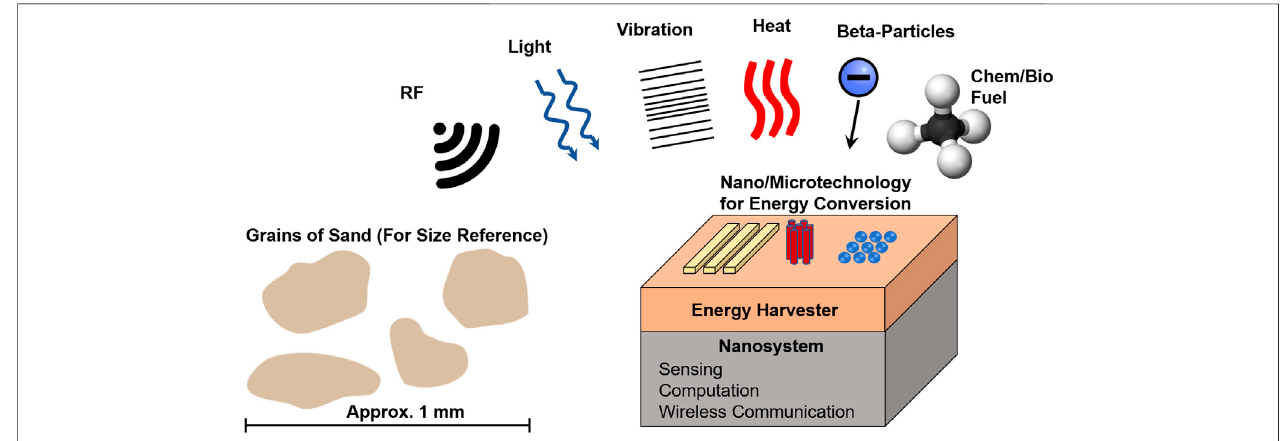
FIGURE 1 | Illustration of an example nanosystem and various modalities for energy harvesting.